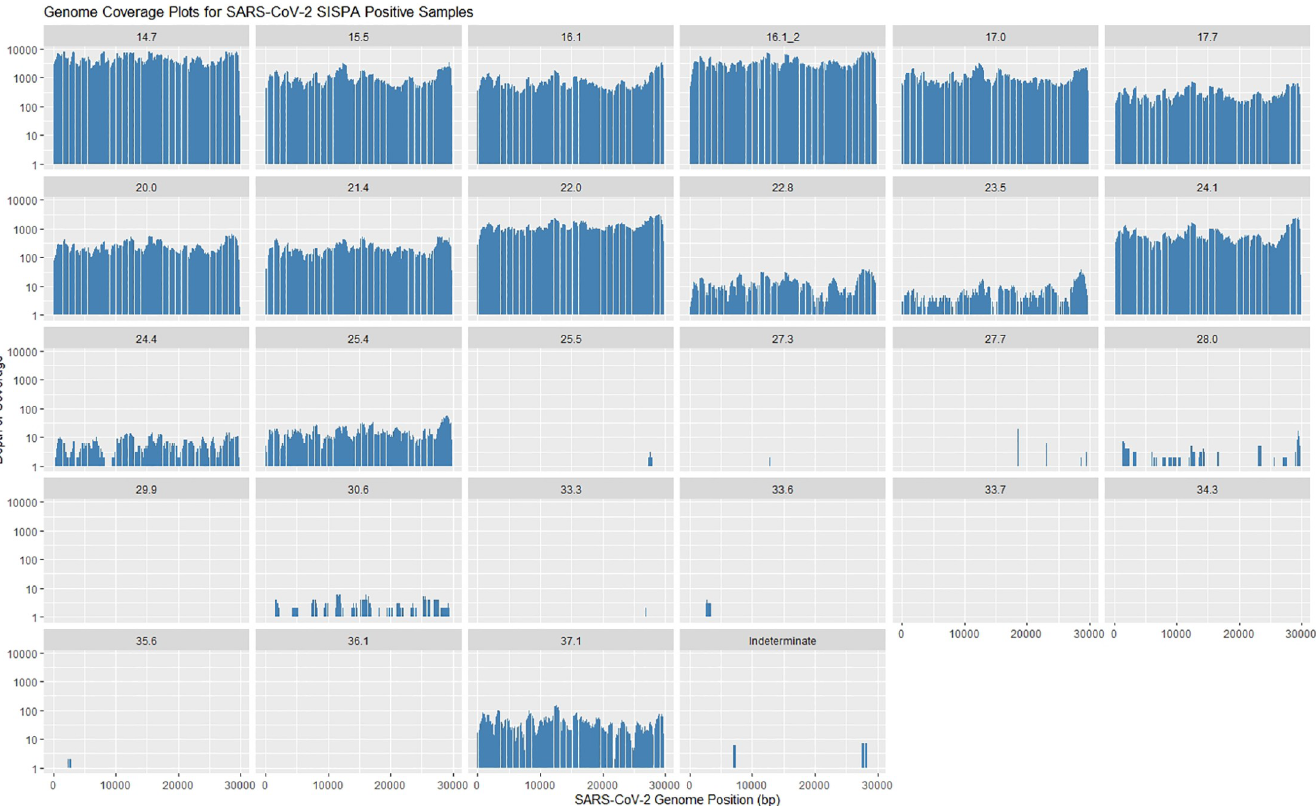
Fig 2. Coverage depth for samples classified as positive by our classifier with log depth of coverage on the y-axis and SARS-CoV-2 reference genome position on the x-axis.